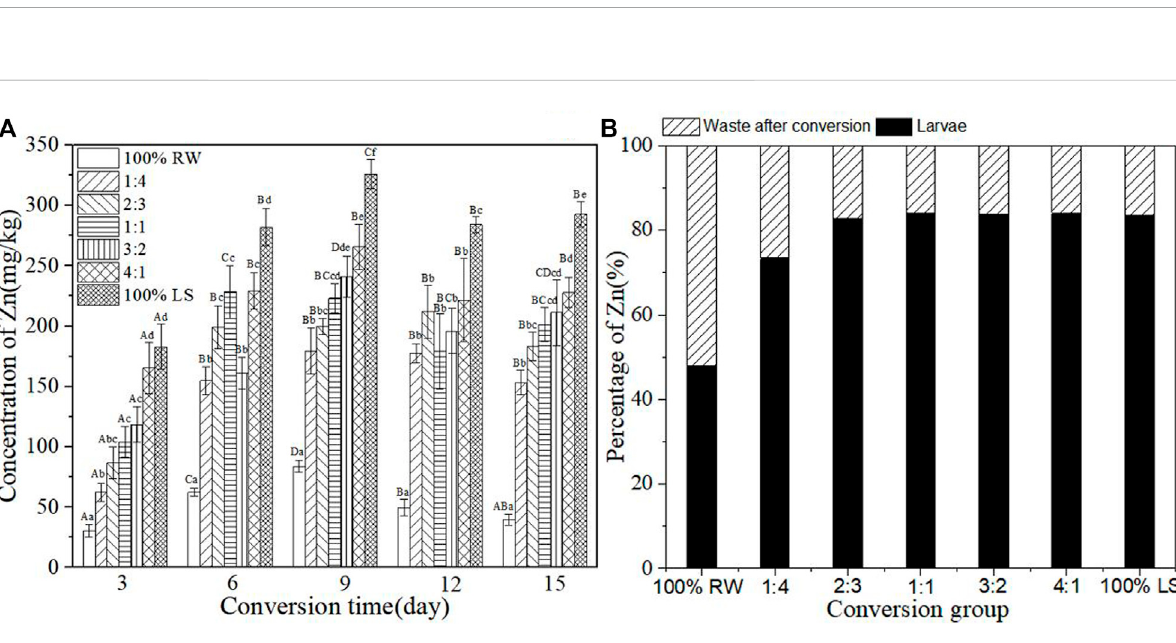
FIGURE 4 (A) -Concentration of heavy metal Zn in BSFL during the conversion; (B) -Percentage of Zn in larvae and waste after conversion. 100% LS:100% lake sediment, 100% RW:100% restaurant waste. The small letters in the Figure 4A indicate the signi fi cance of heavy metal content in BSFL in different